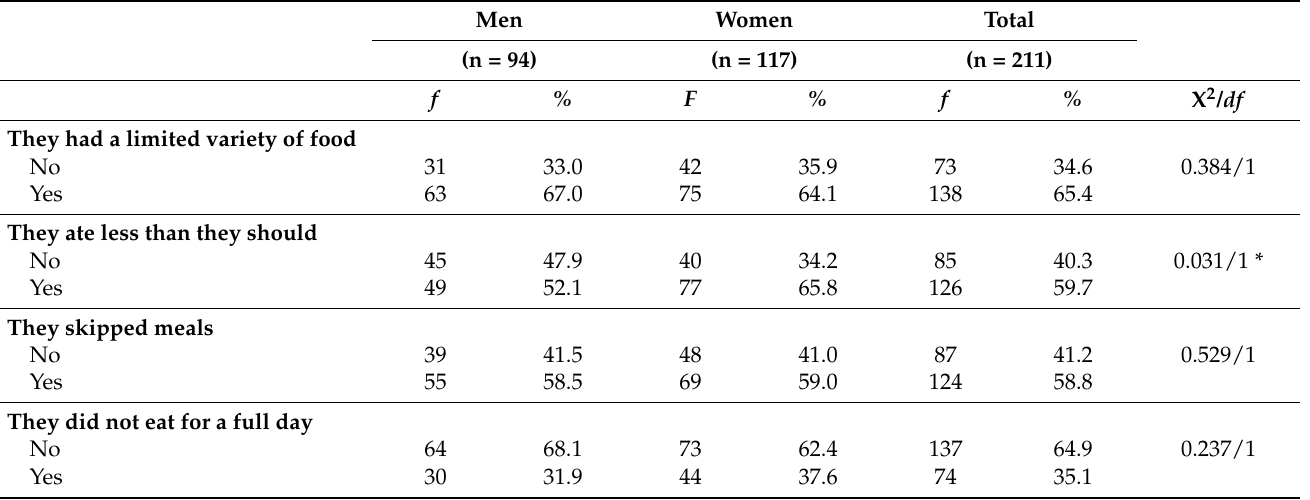
Table 2. Food insecurity: during your current stay in Tijuana, did you experience a lack of money or other